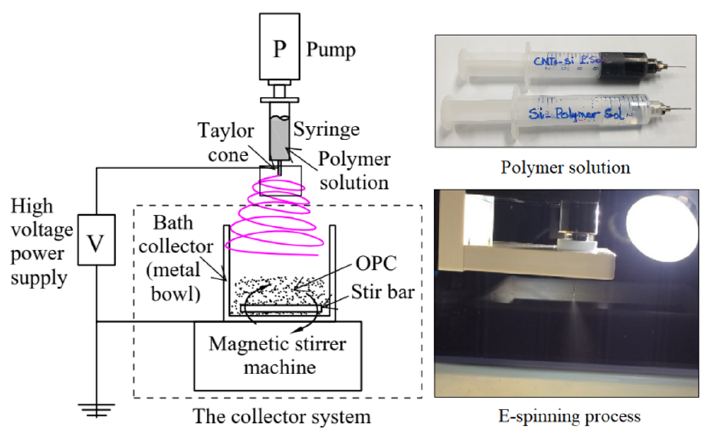
Figure 1. Electrospinning process and polymer solutions.